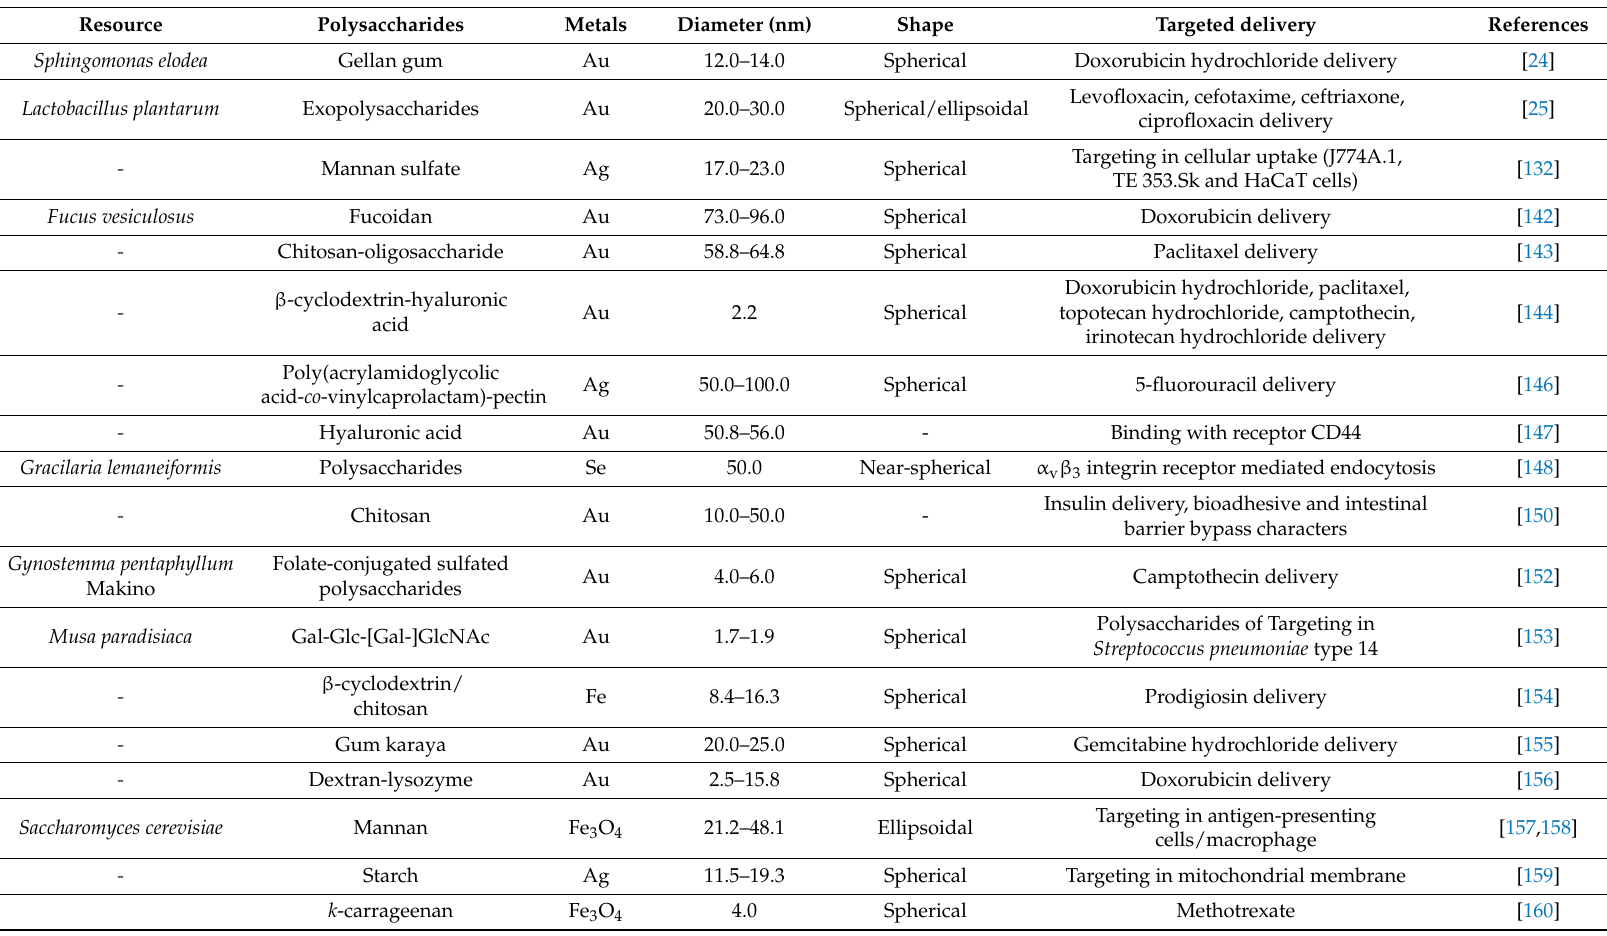
Table 3. Summary of literature data regarding the targeted delivery property of